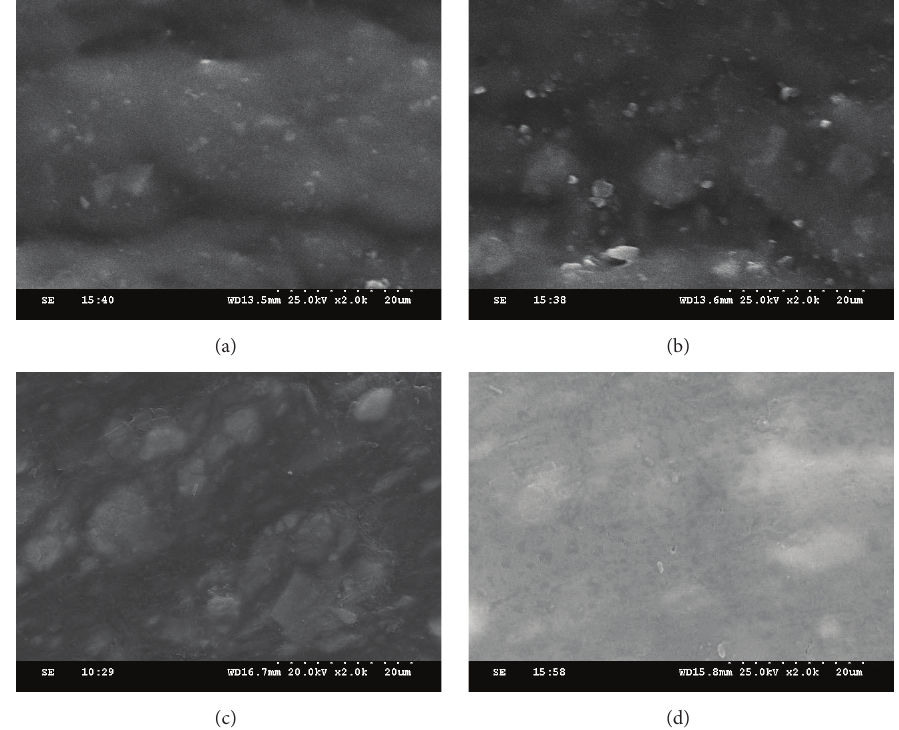
Figure 2: SEM images of the surface of blends ((a) PC/PLA (70/30); (b) PC/PLA/TPU (70/30/20); (c) PC/PLA/TPU (70/30/40); (d) PC/PLA/TPU/DBTO (70/30/30/0.6)).